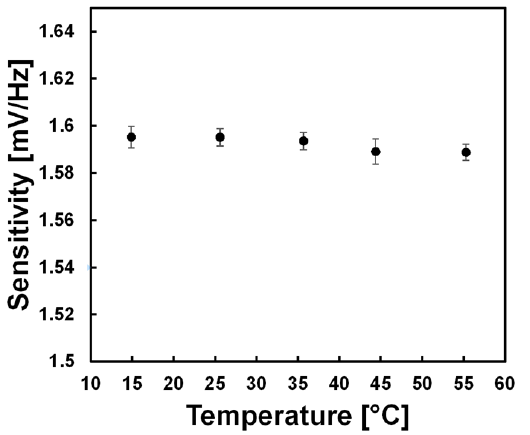
Figure 5. Temperature dependence of system sensitivity. Error bars represent standard deviations of five replicate measurements. Table 1. System sensitivity at evaluated temperatures. Averages and standard deviations were calculated by five replicate experiments at different temperatures. Percent relative errors were calculated based on the sensitivity at 25.6 ◦